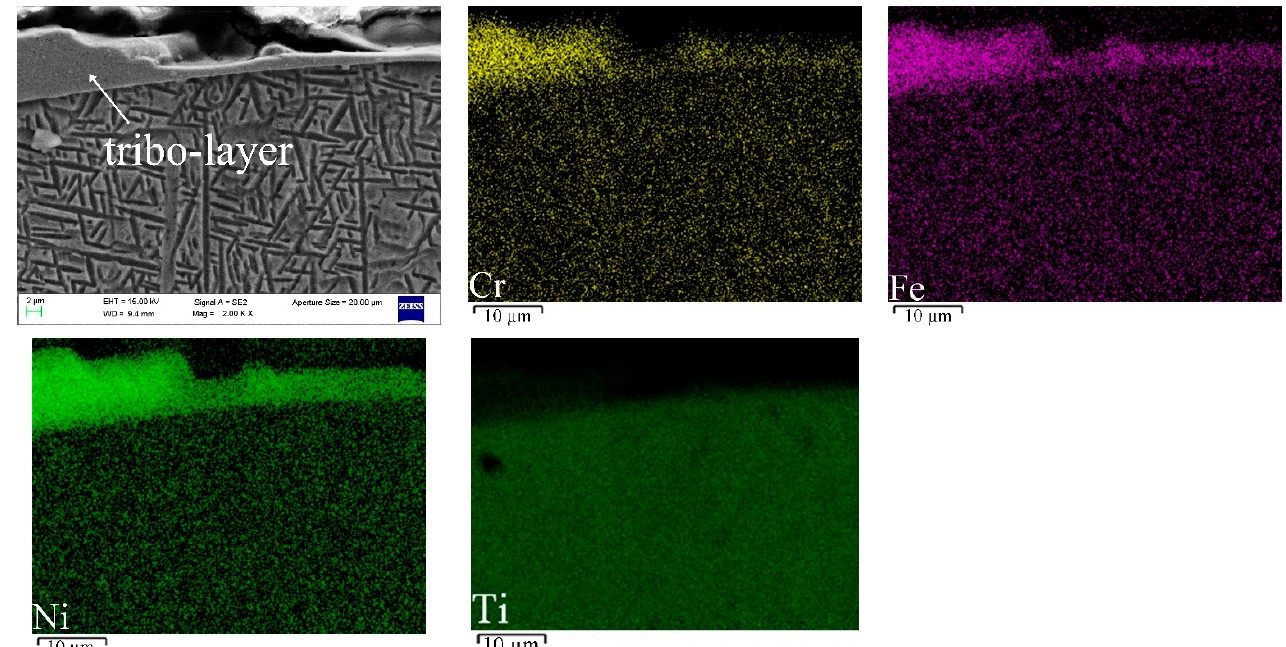
Figure 13. ( a ) The EDS spectrum at 100 μ m/s; ( b ) the weight percentage of five elements at different incursion rates.